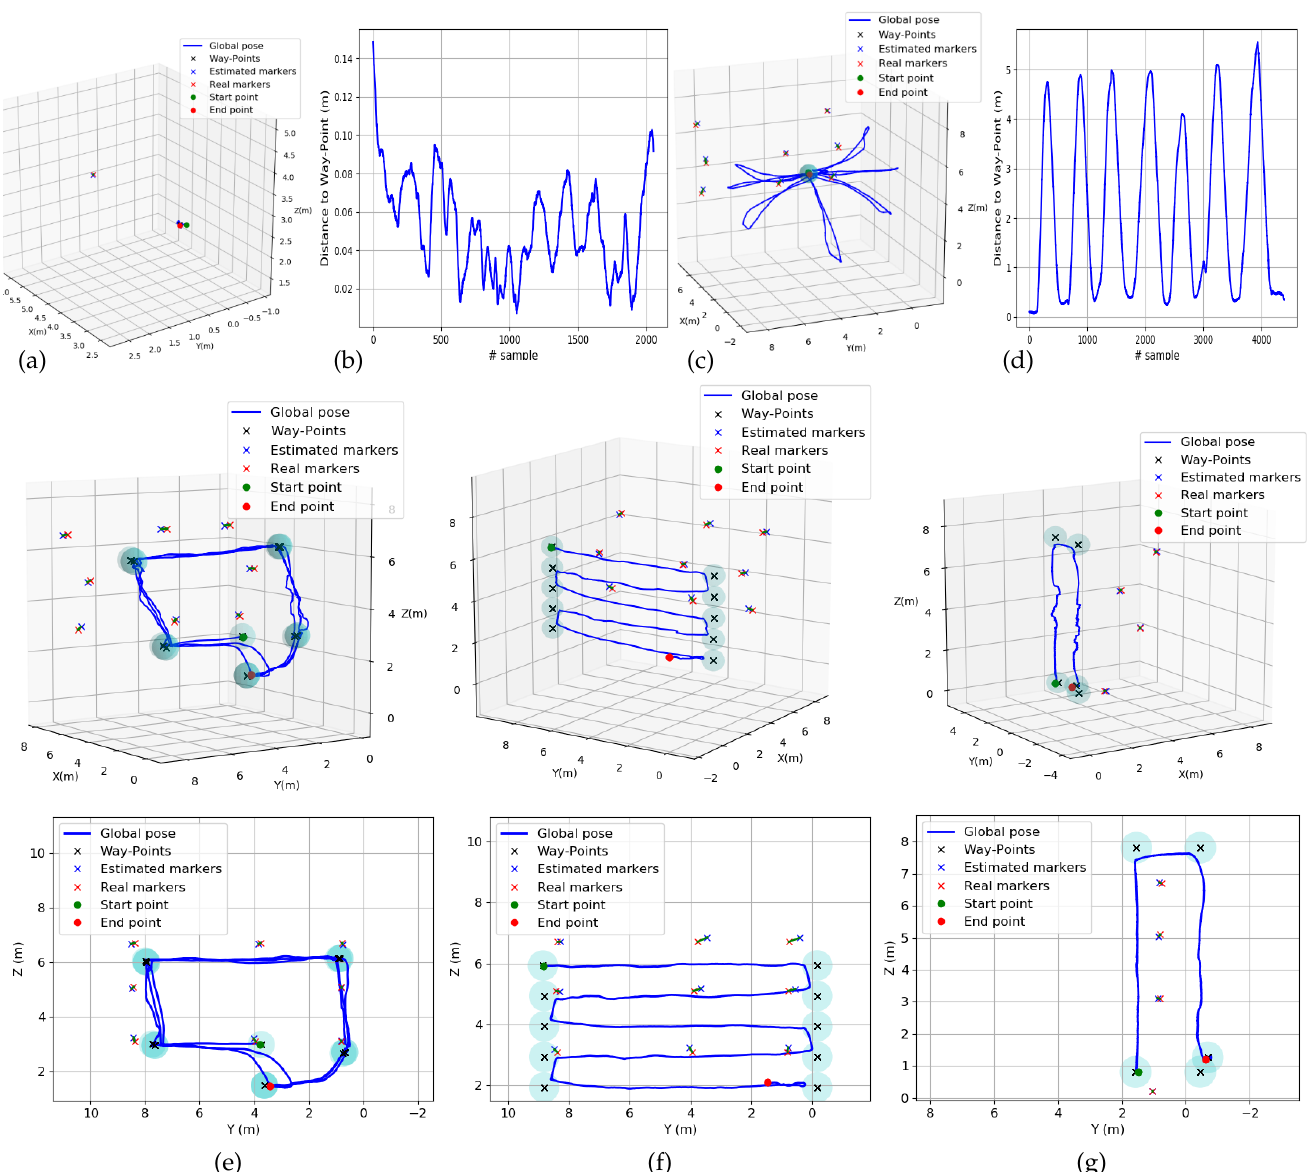
Figure 16. Experiments in a space whose size is similar to a cargo hold: ( a ) estimated path and ( b ) position estimation error for a 1-minute hovering flight; ( c ) estimated path and ( d ) distance to return position for a keep position experiment; ( e ) perspective and 2D projection of estimated path for a way-point visitation experiment, ( f ) for a sweeping flight and ( g ) for a vertical inspection flight. In the plots, × in the center of a blue sphere denotes a way-point. (All units are in